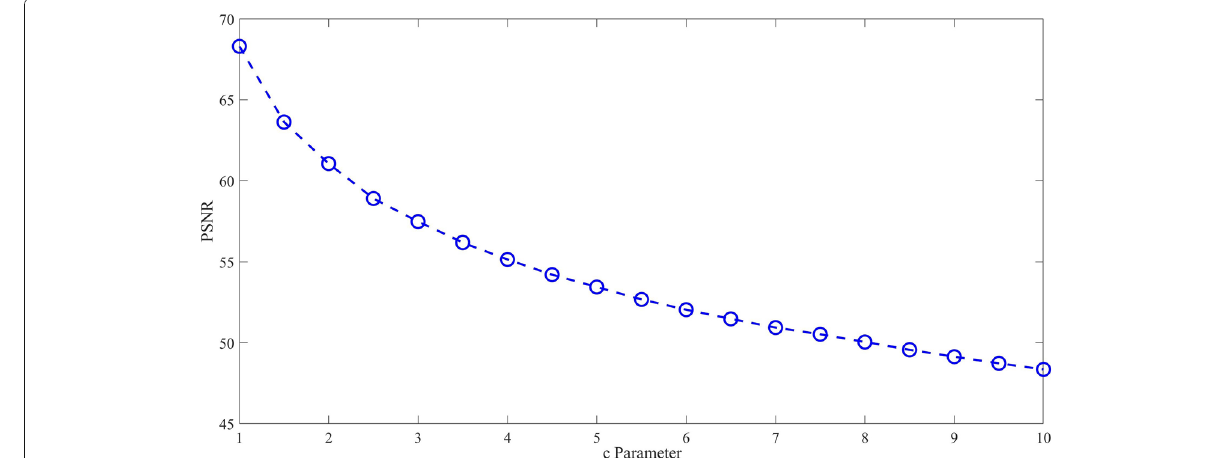
Fig. 8 PSNR vs c Parameter (averaged over 50 images)